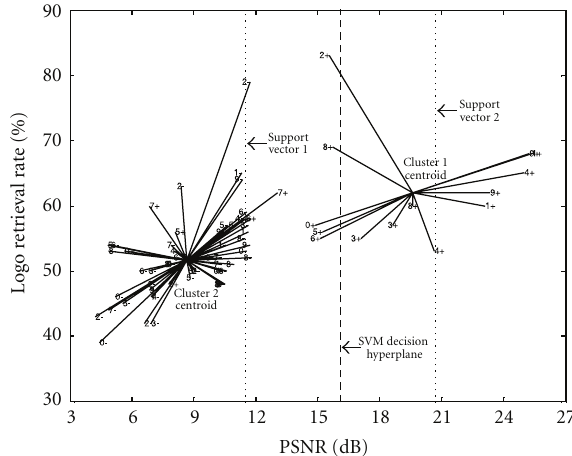
Figure 9: SVM classification and K -means clustering results by the t -DWT ( t = 4) approach of the proposed MSB-based scheme. Note that the distance between support vectors by SVM [27] is d = 25 . 1 and cluster 1 and cluster 2 are positive and negative clusters, respectively, by K -means clustering algorithm [28]. Attack numbers 0–9 are referred using Table 3.